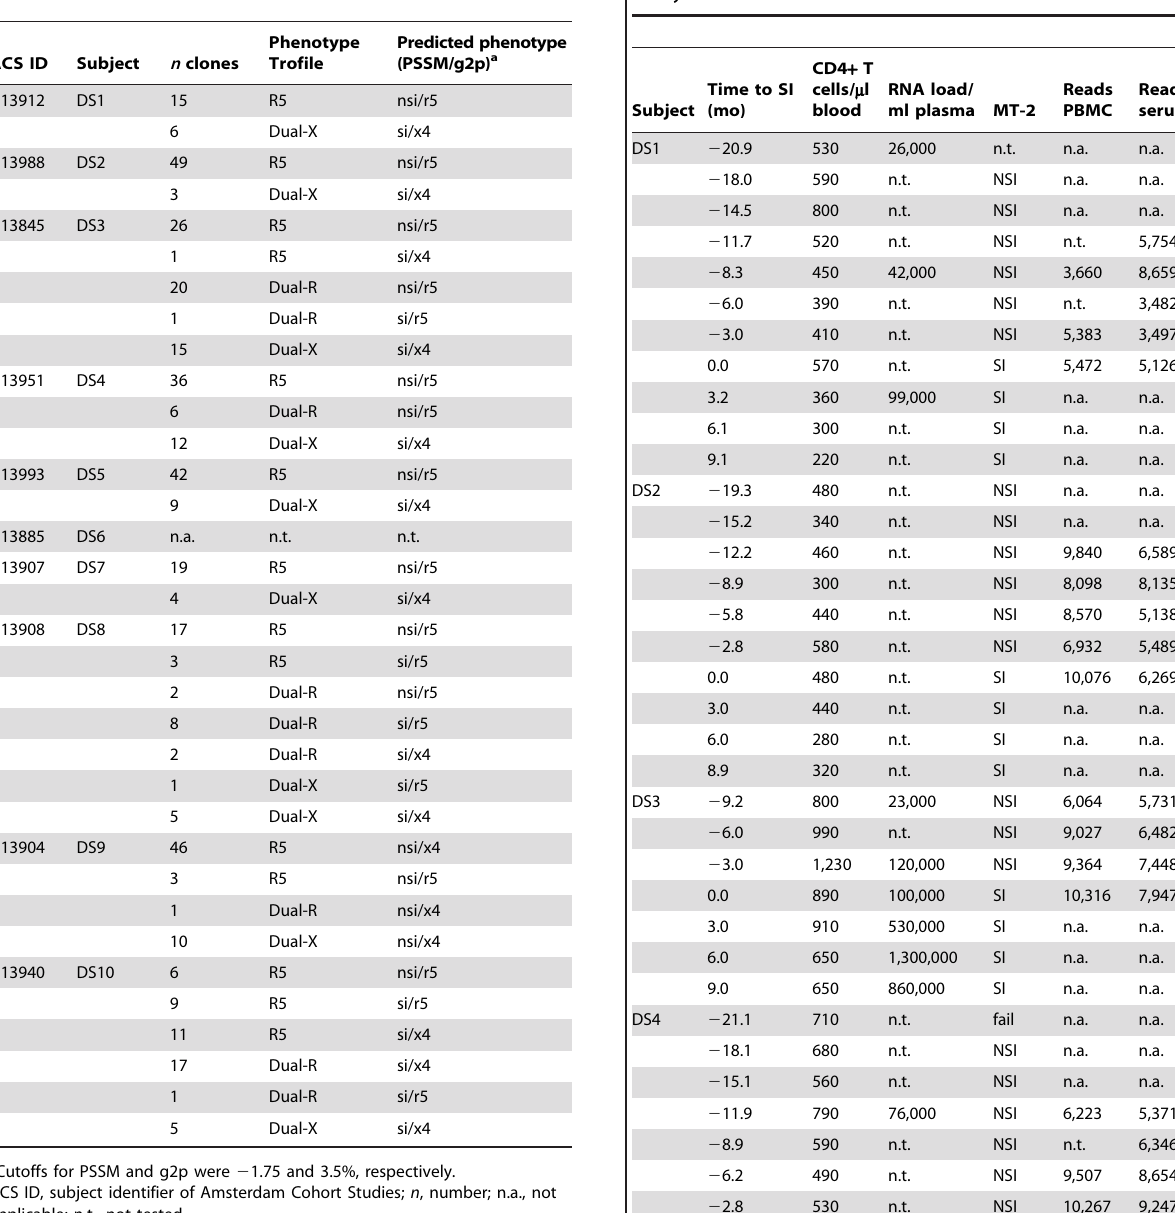
Table 1. Predicted phenotypes of Env clones for which coreceptor usage was determined in the Trofile assay.